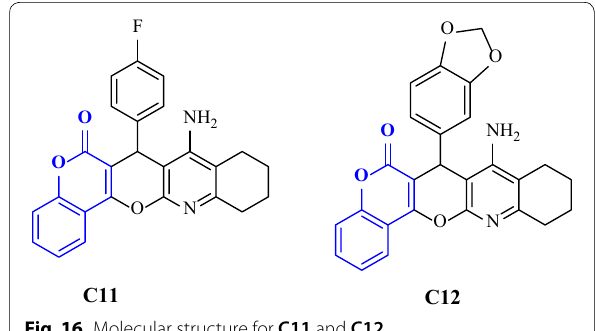
Fig. 16 Molecular structure for C11 and C12